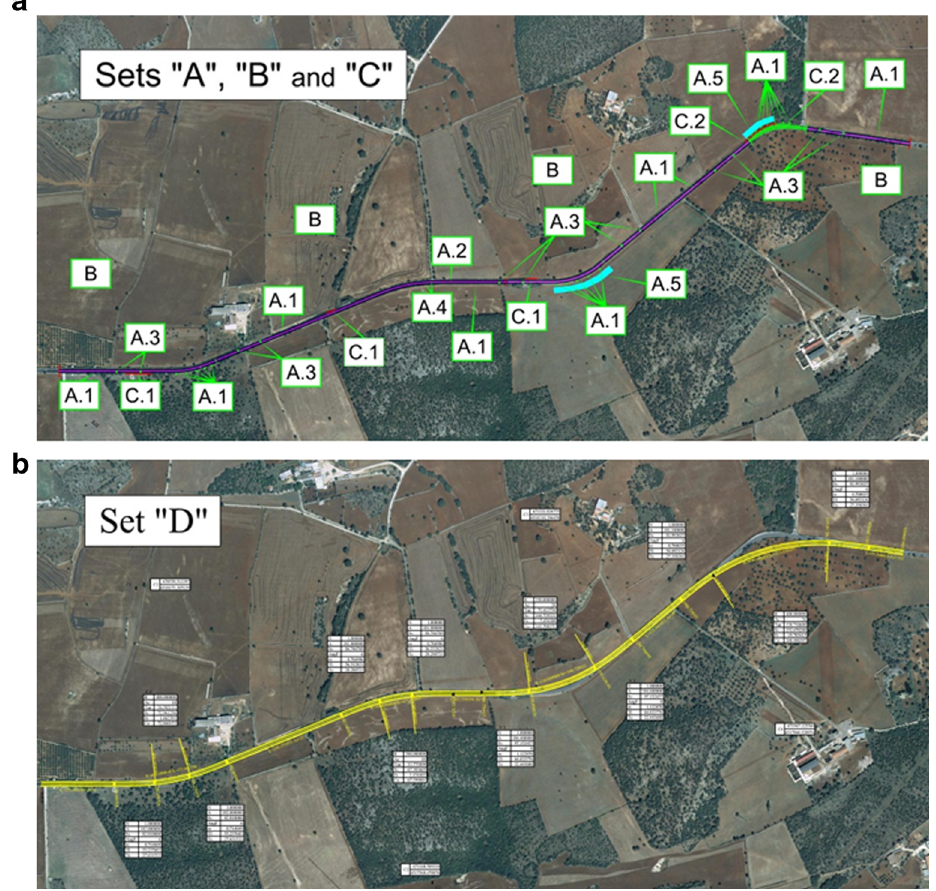
Fig. 11 Example of possible different sets of countermeasures. Site PP1: a short-term safety measures (sets of countermea- sures B A ^ , B B ^ and B C ^ ), b re- design ofthe horizontal alignment (set of countermeasure B D ^ )